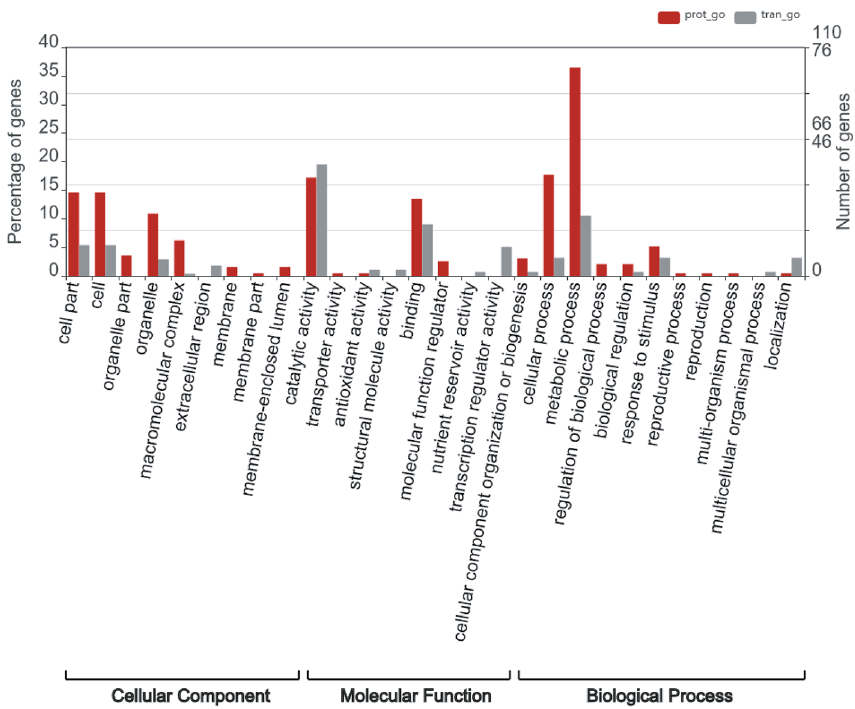
Figure 4. Association analysis of proteomics and transcriptomics. The red column represents the GO enrichment of the proteome, and the green column represents the GO enrichment of the transcriptome. The abscissa displays the enriched GO items, and the ordinate displays the number of enriched proteins (or genes) of the proteome and the transcriptome. The corresponding GO entries of the differential proteins and differential genes were extracted, and the graph was drawn using WEGO (http:// wego. genom ics. org.